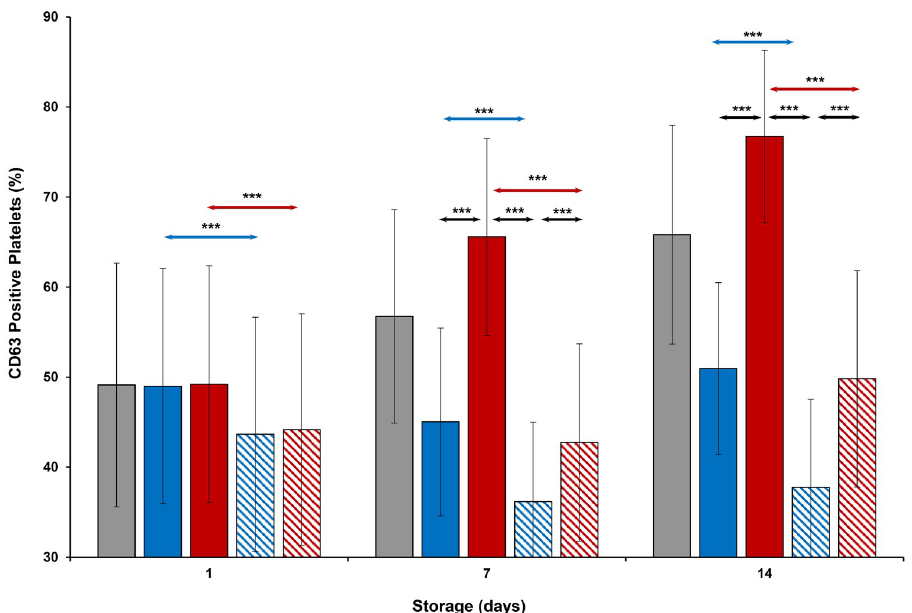
Fig 8. Effects of 14-day storage, temperature and presence of p38MAPK inhibitor on CD63 expression on platelets. Grey bar–platelets stored at room temperature; blue solid bar–cold-stored platelets; red solid bar– thermocycled-stored platelets; blue striped bar–cold-stored + VX-702 platelets; red striped bar–thermocycled-stored + VX-702 platelets. Data represents the mean of 15 experiments with one standard deviation. Arrows represent paired statistical differences; ��� —p <